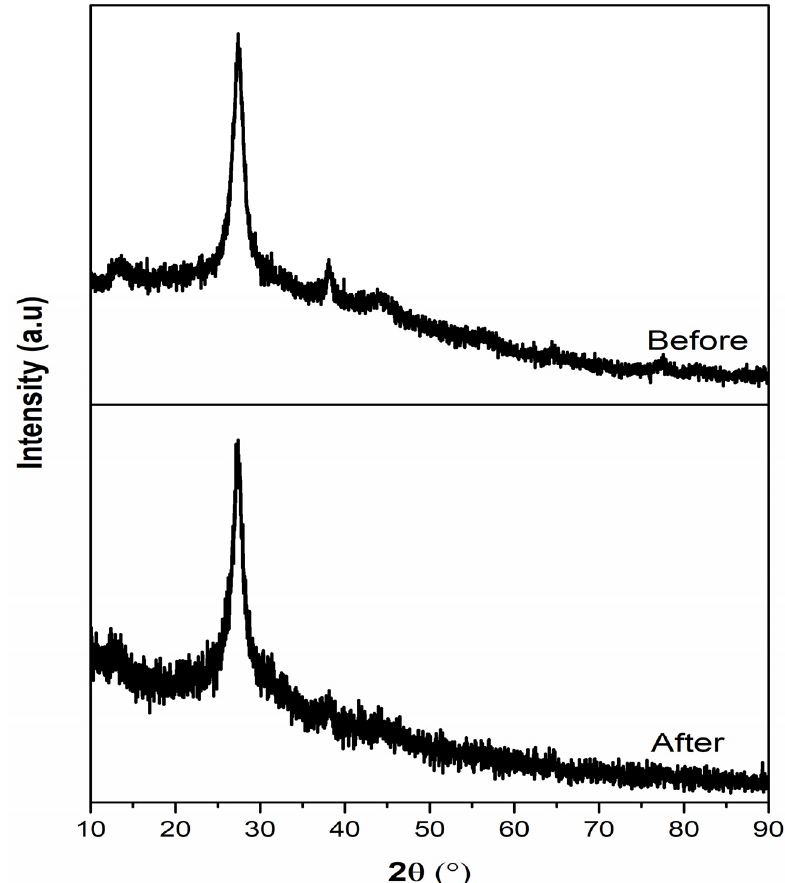
Figure 11. X-ray diffraction spectra of 0.02 Ag/g-C 3 N 4 structures before and after dye degradation.